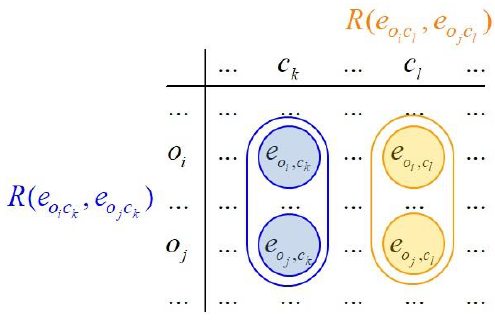
Figure 3. Intercriteria correlations.